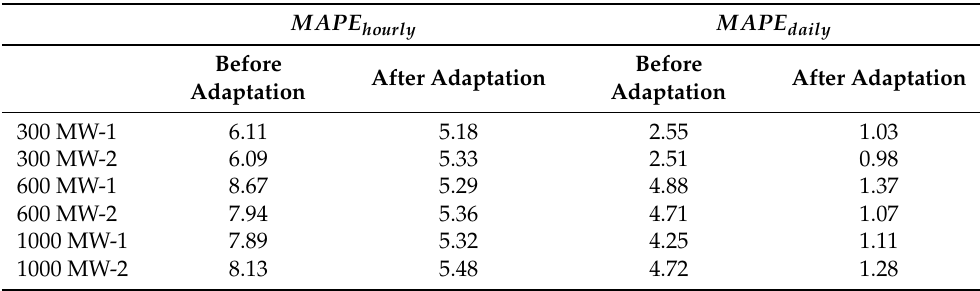
Table 4. Comparing the MAPE of EEN before and after adaptation about daily and hourly CO 2 emission estimation. MAPE hourly MAPE daily Before Before After Adaptation After Adaptation Adaptation